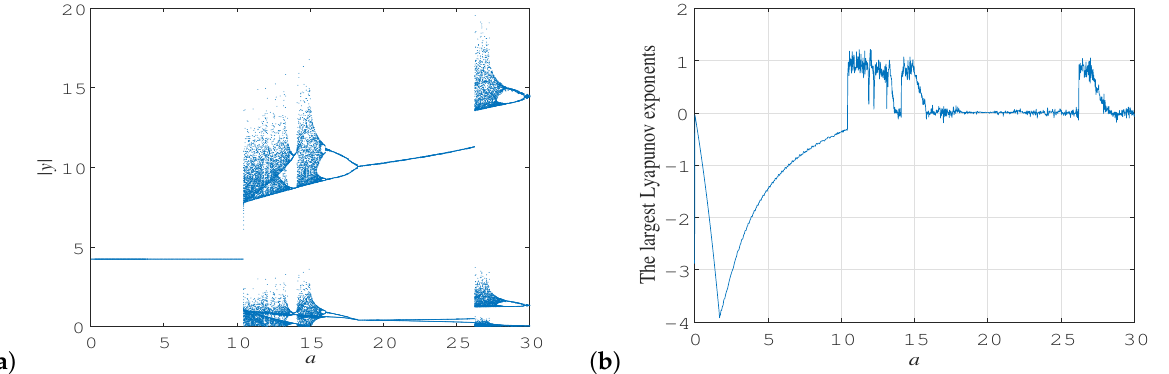
Figure 5. ( a ) Bifurcation diagram and ( b ) largest Lyapunov exponent spectrum versus a, where b = 100, c = 10, and k =